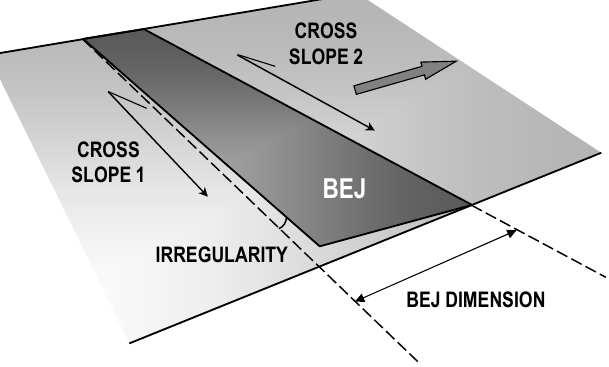
Figure 1. Irregularity between bridge expansion joint (BEJ) and the road in a transition curve.